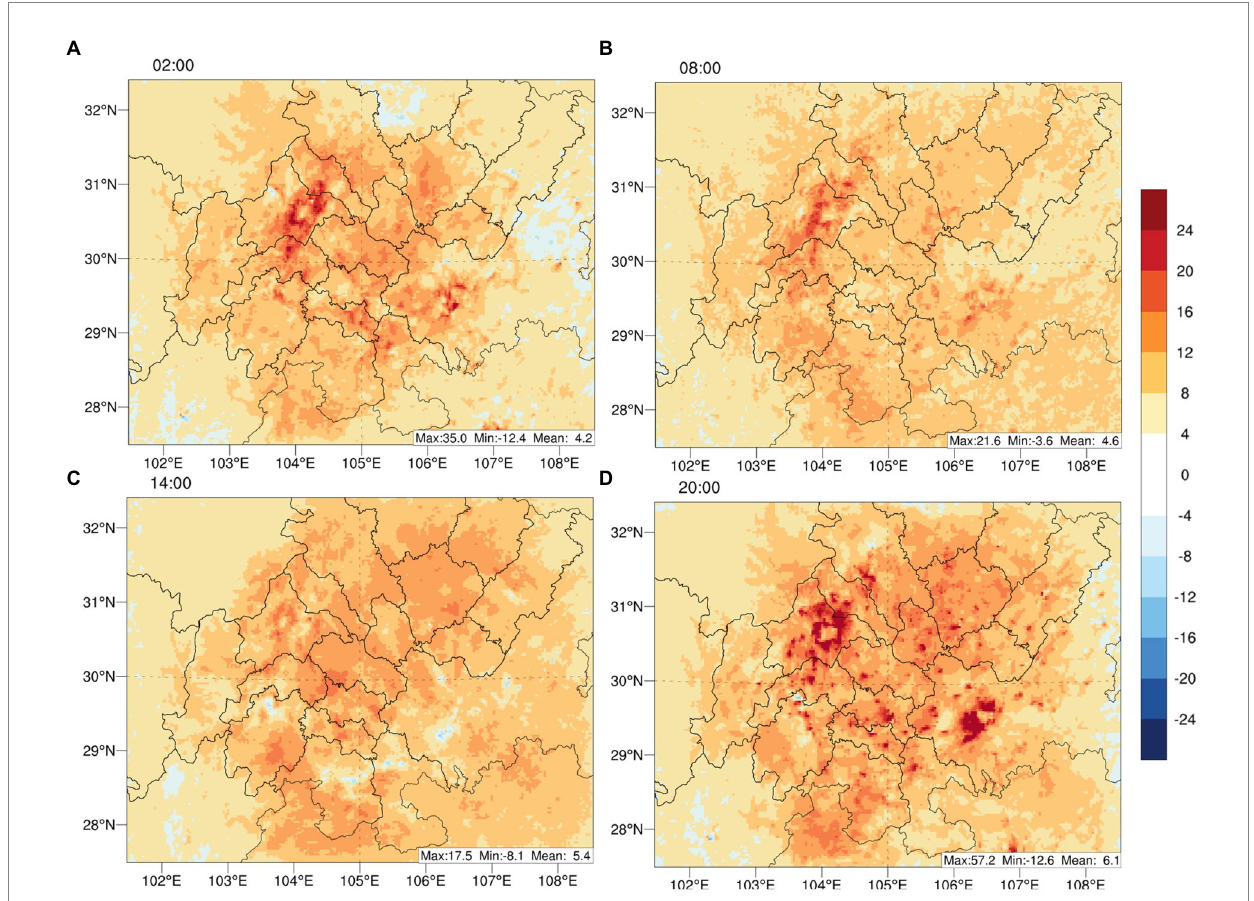
FIGURE 6 Differences in simulated monthly-averaged O 3 between 2019LULC and WRF_default scenarios at 02:00, 08:00, 14:00, 20:00 over the SCB in August